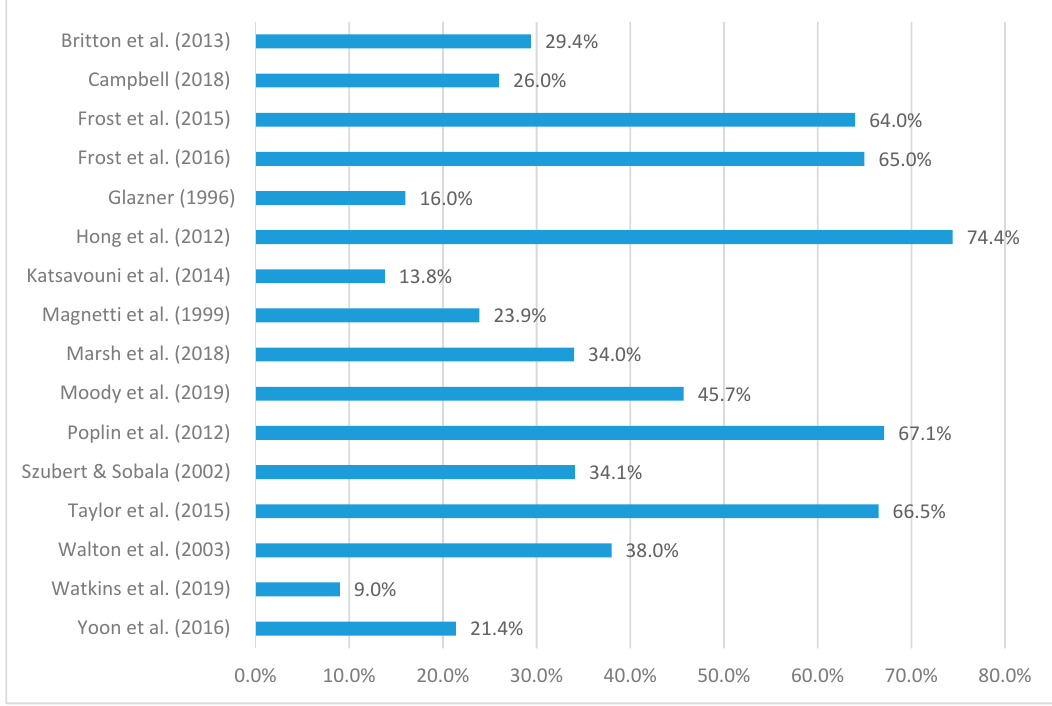
Figure 2. Musculoskeletal injury prevalence, by study.